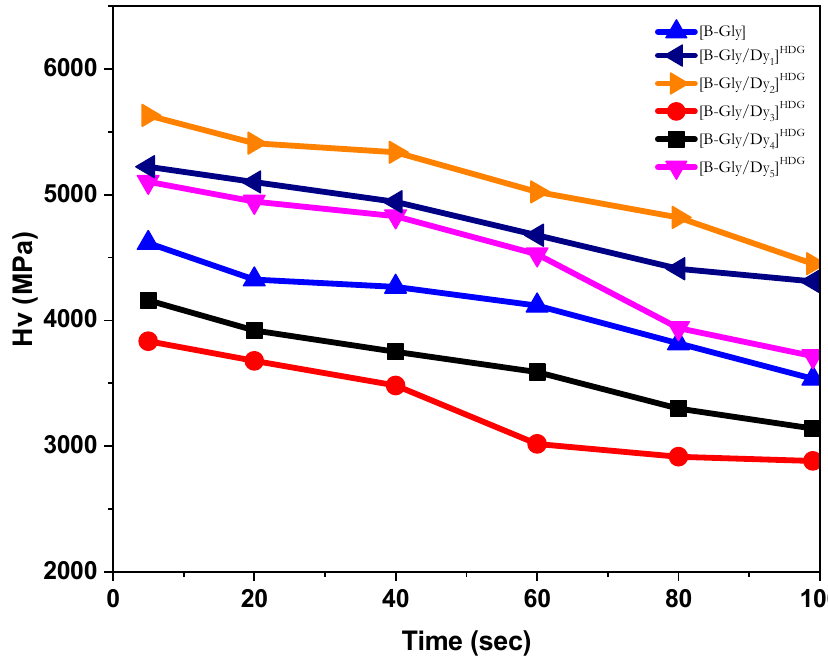
Figure 9. Variation of hardness with time at constant load 100 gf.